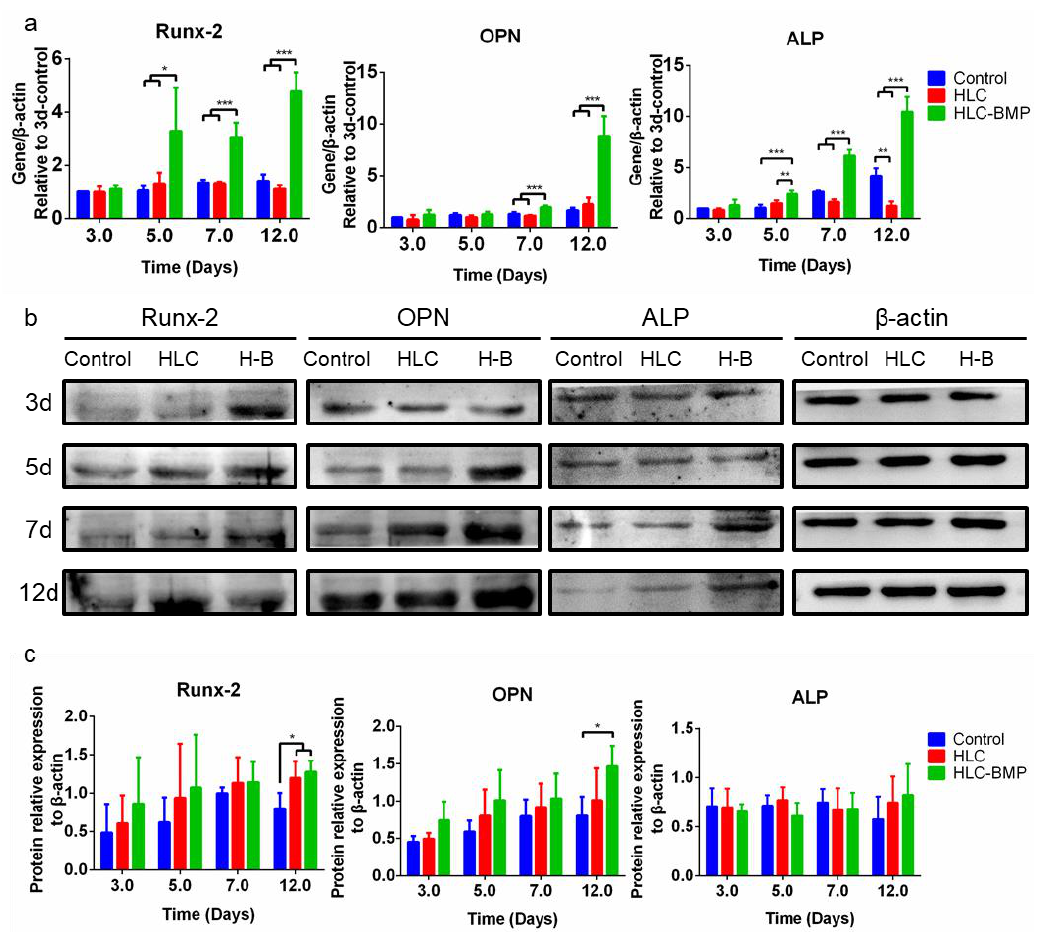
Figure 4. Osteoblast di ff erentiation levels in the MSCs cultured in the HLC / HLC-BMP (1 µ g) sponges. ( a ) To explore the mechanisms involved, gene expression levels of osteo-related genes ( Runx-2 , OPN, and ALP ) were assessed by Real-time PCR ( * p < 0.05, ** p < 0.01, *** p < 0.001, n = 3). ( b , c ) Runx-2, OPN, and ALP protein expression levels were assessed using Western blot (* p < 0.05, n = 3). Runx-2, OPN, and ALP protein levels were also checked with a Western blot. ALP expressed in